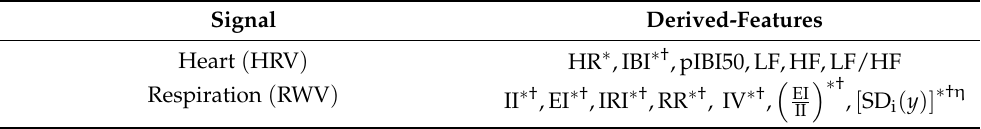
Table 1. HRV and RWV classification features. Signal